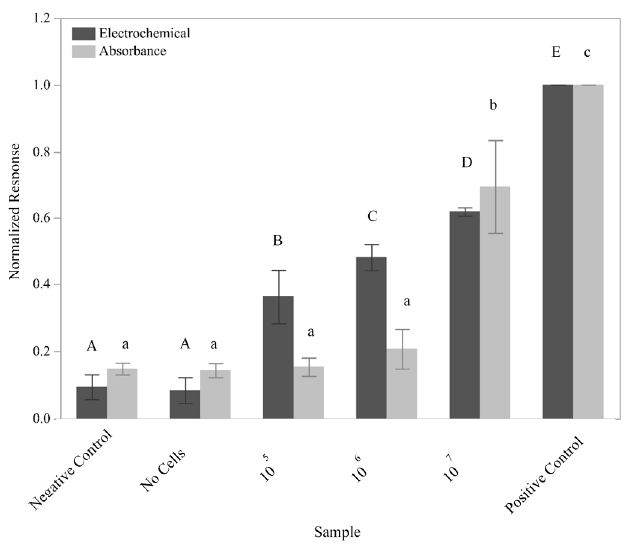
Figure 5. Detection of L. monocytogenes from live cells. The normalized response was determined using both electrochemistry (dark gray bars) and absorbance (light gray bars) upon exposure of the sensor to a series of lysed L. monocytogenes cells in a 5 mL sample volume. Exposure of the sensor to buffer only (no cells), sensors that did not contain capture oligo (negative control), and the positive control were also performed. The mean response from three independent trials is plotted with the standard deviations and statistical differences amongst samples noted by the connecting letters report. Levels not connected by the same letter are significantly